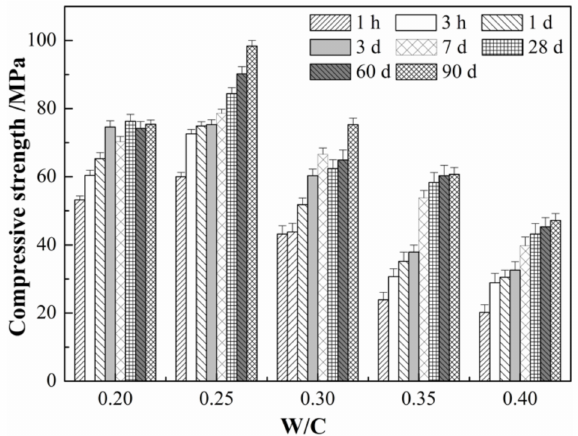
Figure 5. Influence of W/C ratios on the compressive strength of SLMKPC